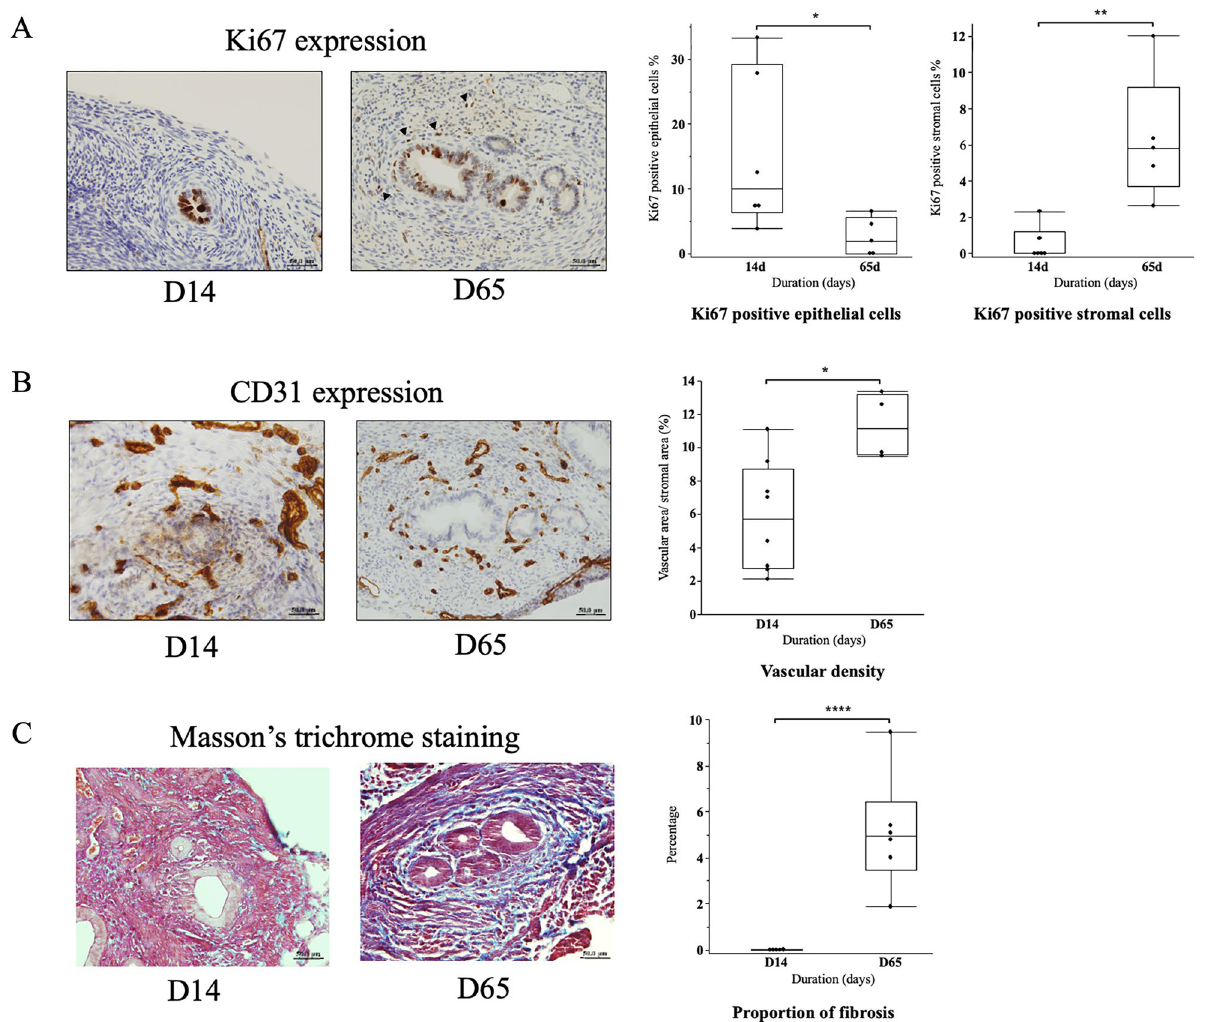
Figure 3. ( A ) A representative microscopic image of Ki67 expression in adenomyosis lesion (× 400) and a box and whisker graph of the percentage of Ki67 positive cells Ki67 is positive in the nuclei of both epithelial and stromal cells (arrowheads) in the adenomyosis lesion at the 14th (D14) (left) and the 65th (D65) (right) postoperative day. In epithelial cells, the percentage of Ki67 positive cells was significantly higher in D14 than in D65 (p < 0.05), while in stromal cells, the percentage was significantly higher in D65 than in D14 (p < 0.01). ( B) A representative microscopic image of CD31 expression in adenomyosis lesion (×400) and a box and whisker graph of vascular density. CD31, a marker for endothelial cells, was used to detect blood vessels. Blood vessels within the lesion were identified, the cross-sectional area of blood vessels was measured, and this was divided by the cross-sectional area of adenomyosis lesion to calculate the vascular density. Vascular density in D65 was significantly higher than that in D14 (p < 0.05). ( C ) A representative microscopic image of Masson’s trichrome staining of adenomyosis lesion (×400) and a box and whisker graph of percentage of fibrotic area. Areas of fibrosis (collagen deposition) were stained blue. The percentage of fibrosis area in D65 was significantly higher than that in D14 (p < 0.001). Box: 25–75%, whisker: 10–90%, midline: median, *p < 0.05, **p < 0.01, ****p <